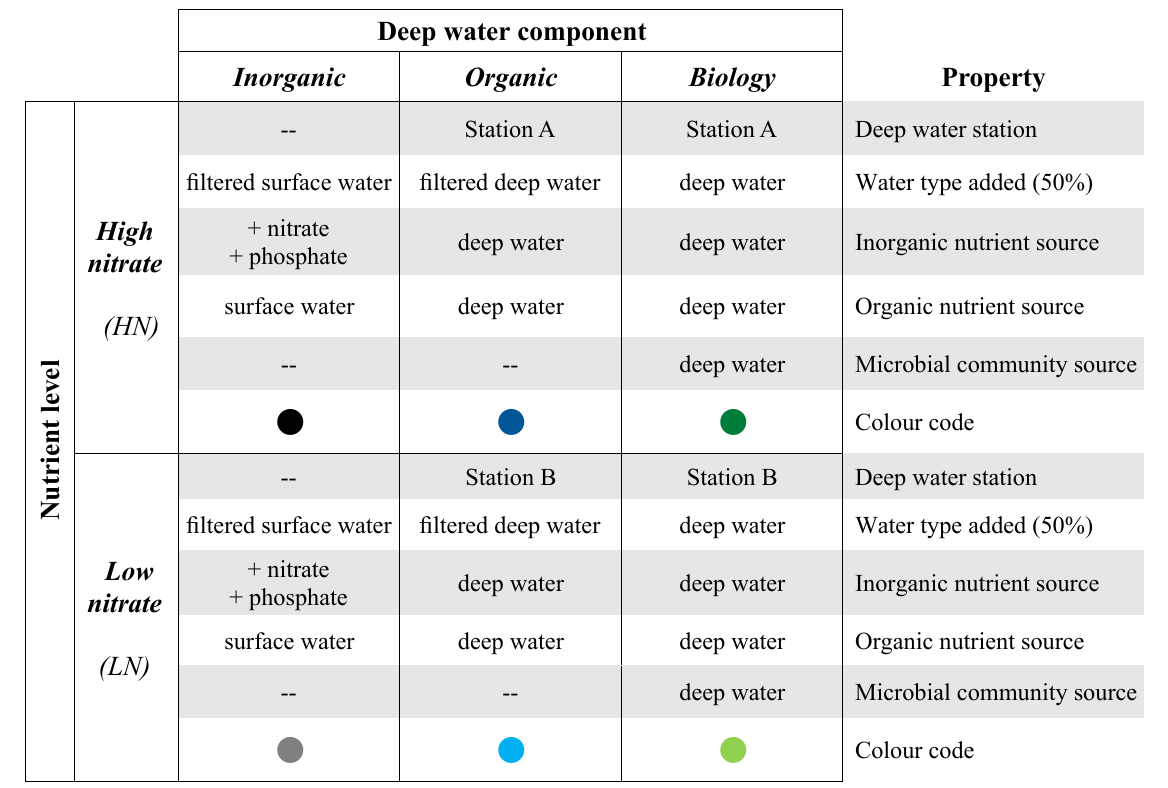
Table 1. Experimental design indicating the six treatment combinations implemented. Each of the six treatment combinations had four replicates. “Filtered” refers to filtration through 0.1µm. Sources of inorganic/organic nutrients and the microbial community are in addition to the 50% of mesocosm surface water used as a base in all six treatment combinations. Details of the water collection and treatment implementation are provided in Sect.